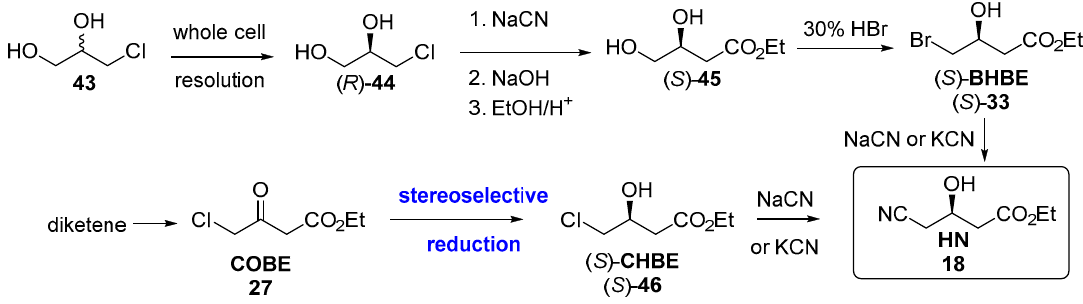
Figure 10. Different chemical methodologies for the preparation of HN 18 .